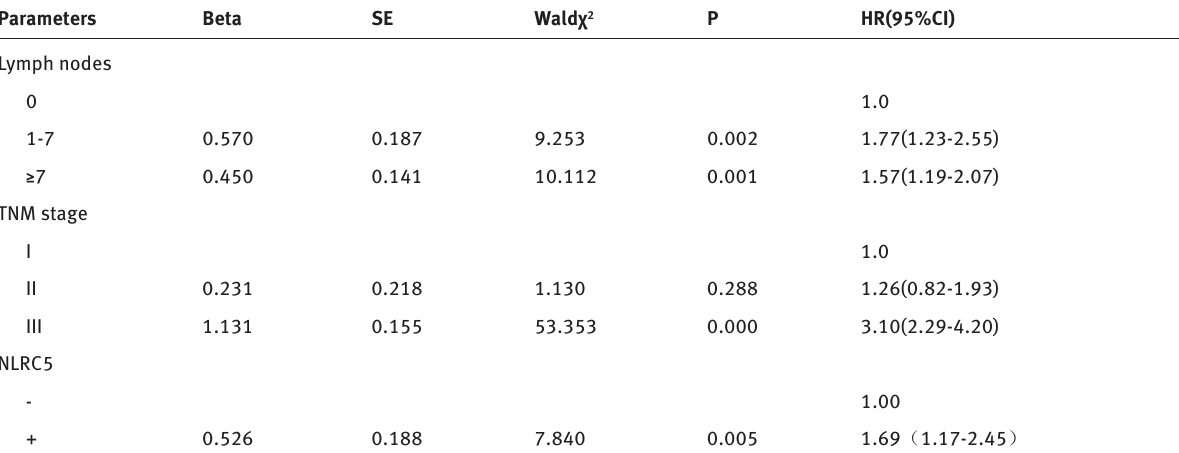
Table 3: Multivariate Cox regression analysis of relationship between clinicopathological characteristics and prognosis in patients with gastric cancer